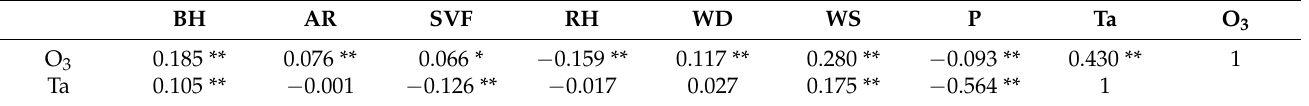
Table 2. Pearson correlation coefficients (r) between pairs of O 3 concentration and building